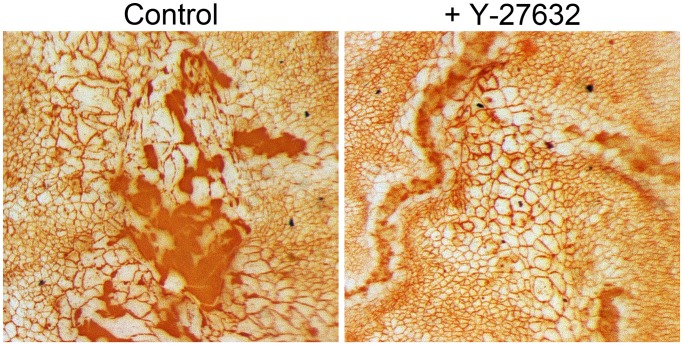

Ex vivo wound healing assessment.Y-27632 induces a totally wound closure after 12+/−4 days, while acellular areas could be still observed in the control group. Treated endothelial cells appear bigger than cells from unwounded region and have a regular shape. A pleomorphism is detected in the control group. (Magnification 60x).